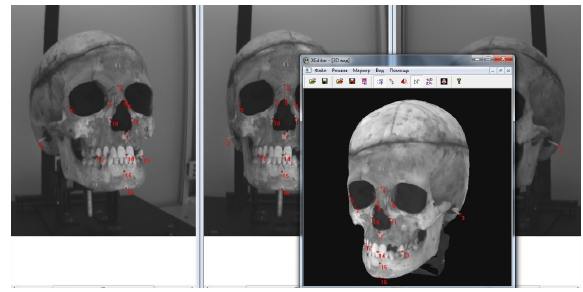
Figure 5. Craniometric landmarks